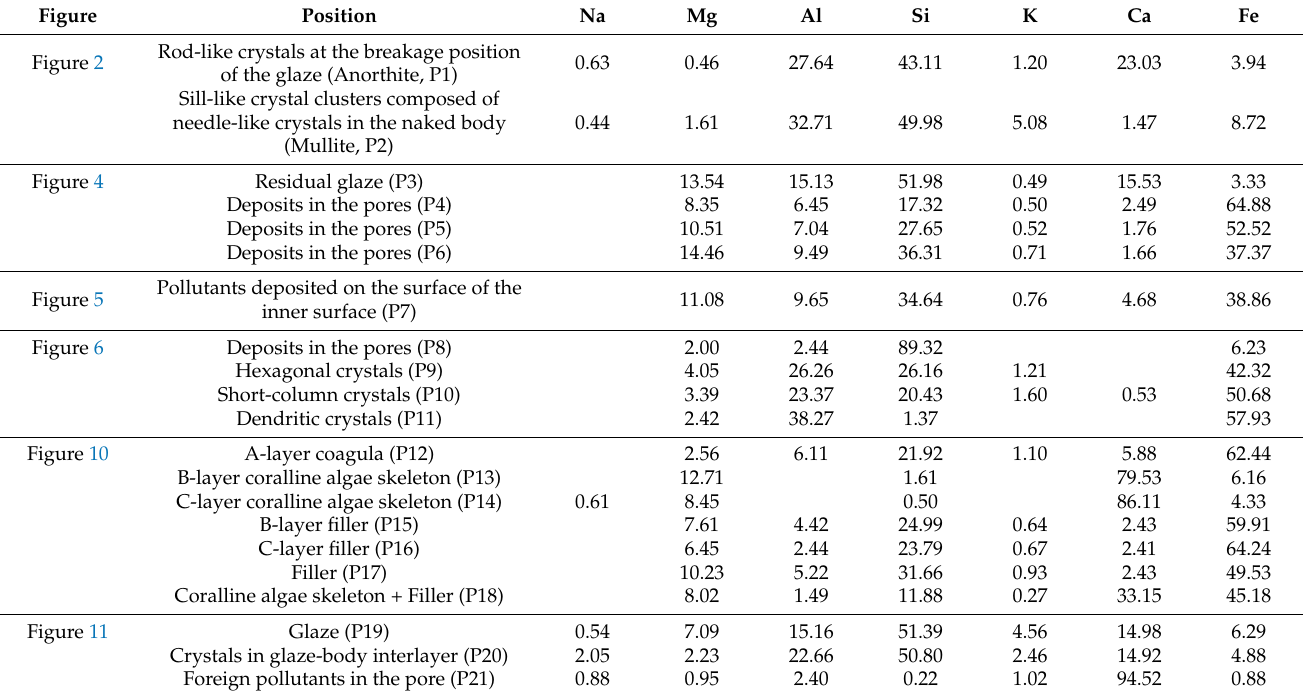
Table 2. EDS analysis results of samples DL-1~3 (wt%).